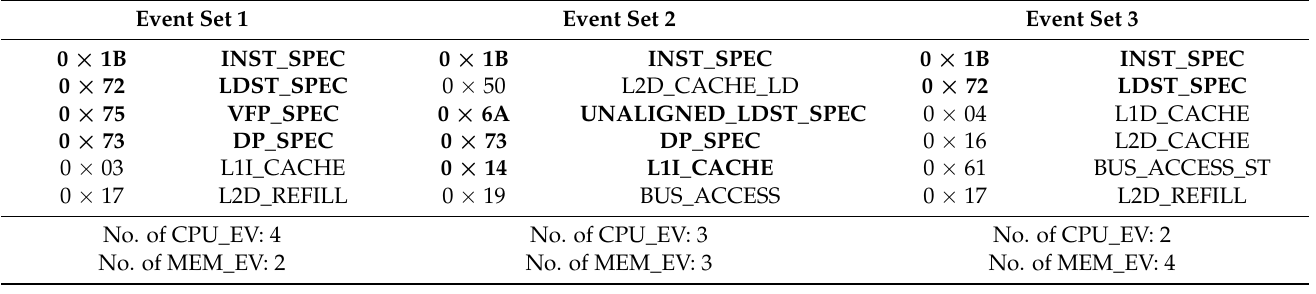
Table 2. Three event sets used in motivational studies.